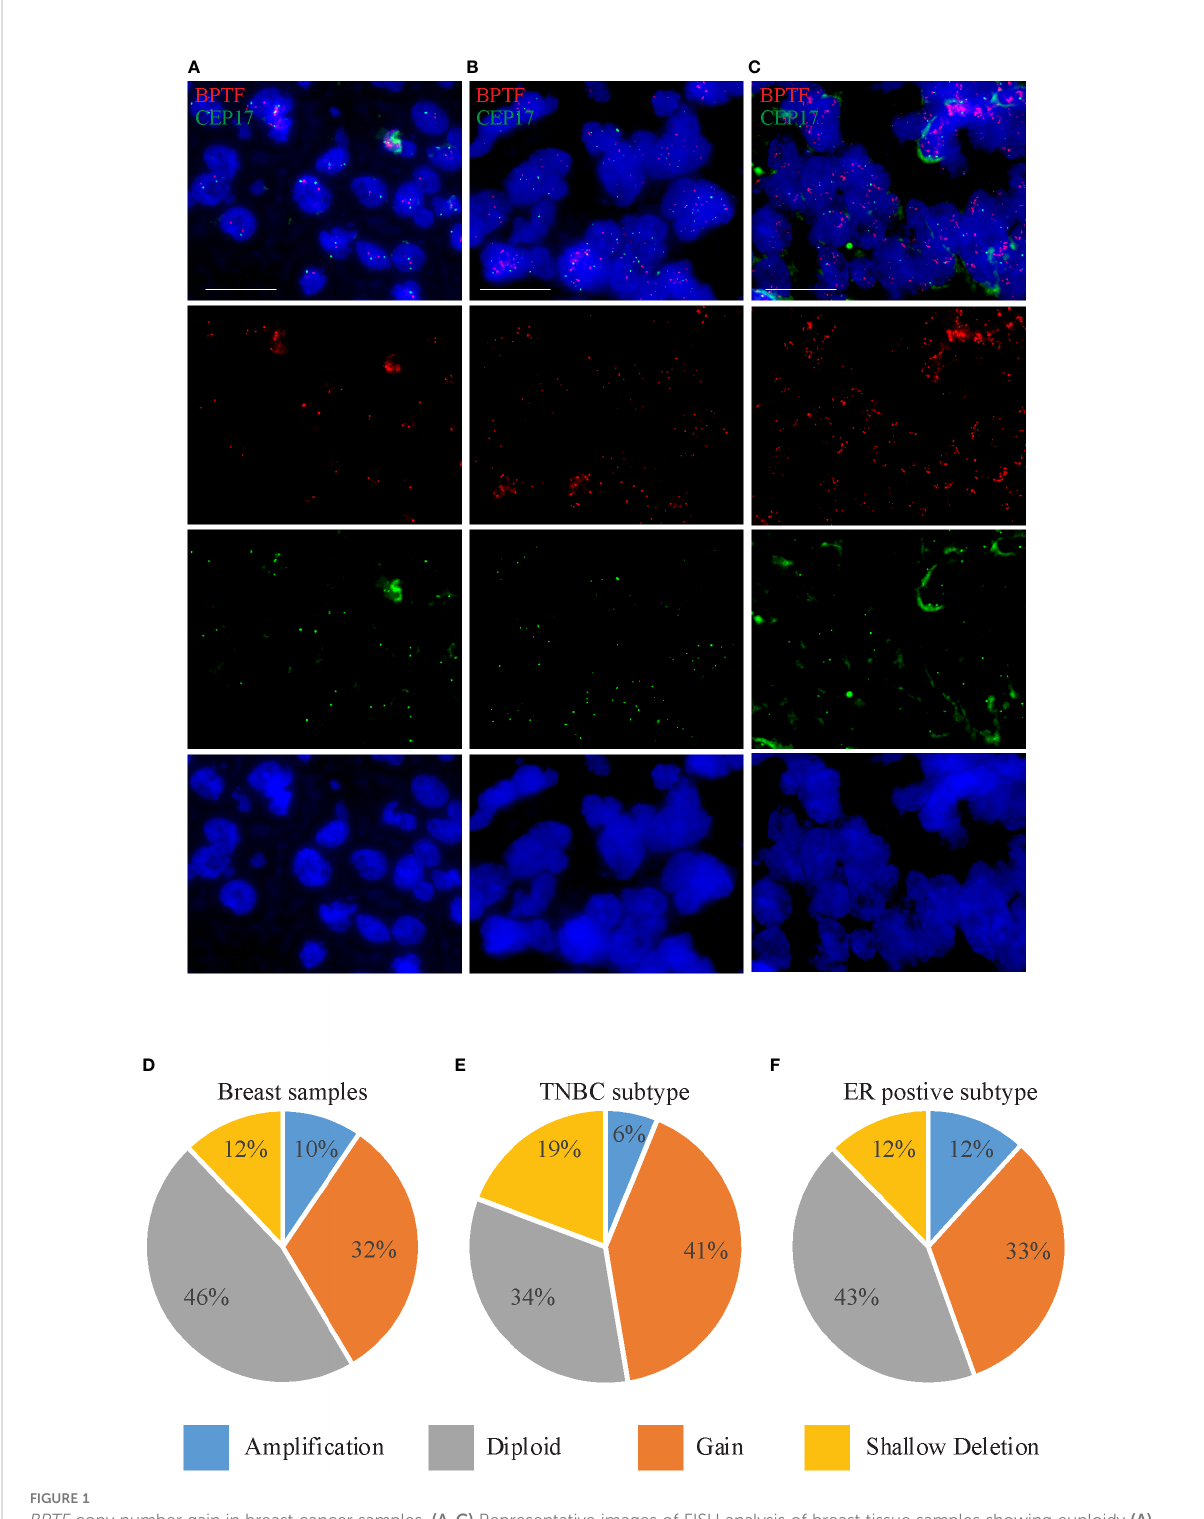
FIGURE 1 BPTF copy number gain in breast cancer samples. (A-C) Representative images of FISH analysis of breast tissue samples showing euploidy (A) , gain (B) and ampli fi cation (C) in BPTF copy number. (D-F) BPTF copy number in all breast cancer samples (D) , as well as TNBC (E) and ER- positive subtypes (F) from TCGA database. Scale bar 20 m